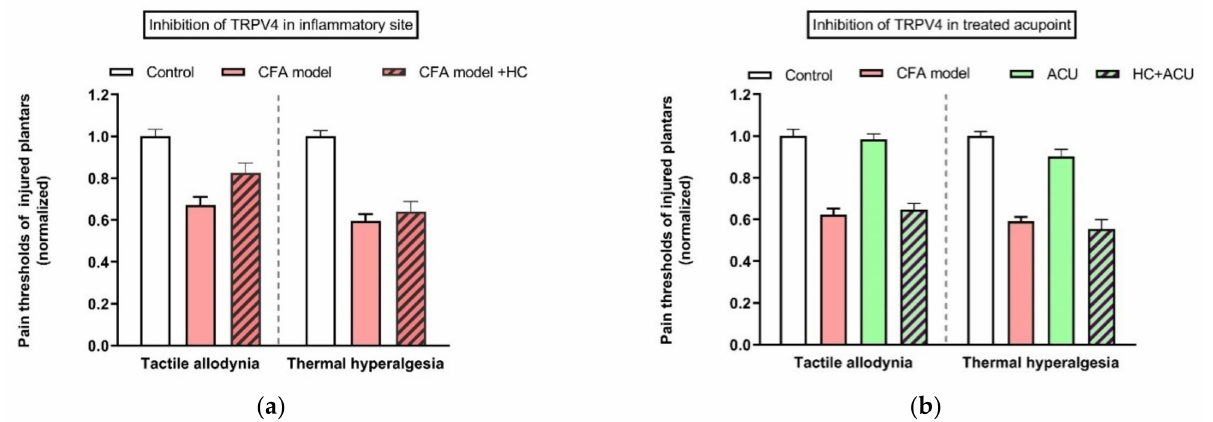
Figure 9. Comparison of TRPV4 channel function at sites of inflammation ( a ) and the treated acupoint ( b ) of ankle AA rats. Establishing the inflammation pain and acupuncture intervention was referred to in the legend of Figure 5. Data show pain thresholds of injured plantars in response to mechanical (tactile allodynia) or heat (thermal hyperalgesia) stimulation. HC067047 (0.2 mM, 20 µ L) (HC), a specific inhibitor of TRPV4, was administrated in the injured plantar 50 min before behavioral test ( a ), or in the treated ST36 20 min before 30-min needling. ( b ) Data represent means + SEM ( n = 6–9), and are based on data from Zheng et al. (2021) [54].